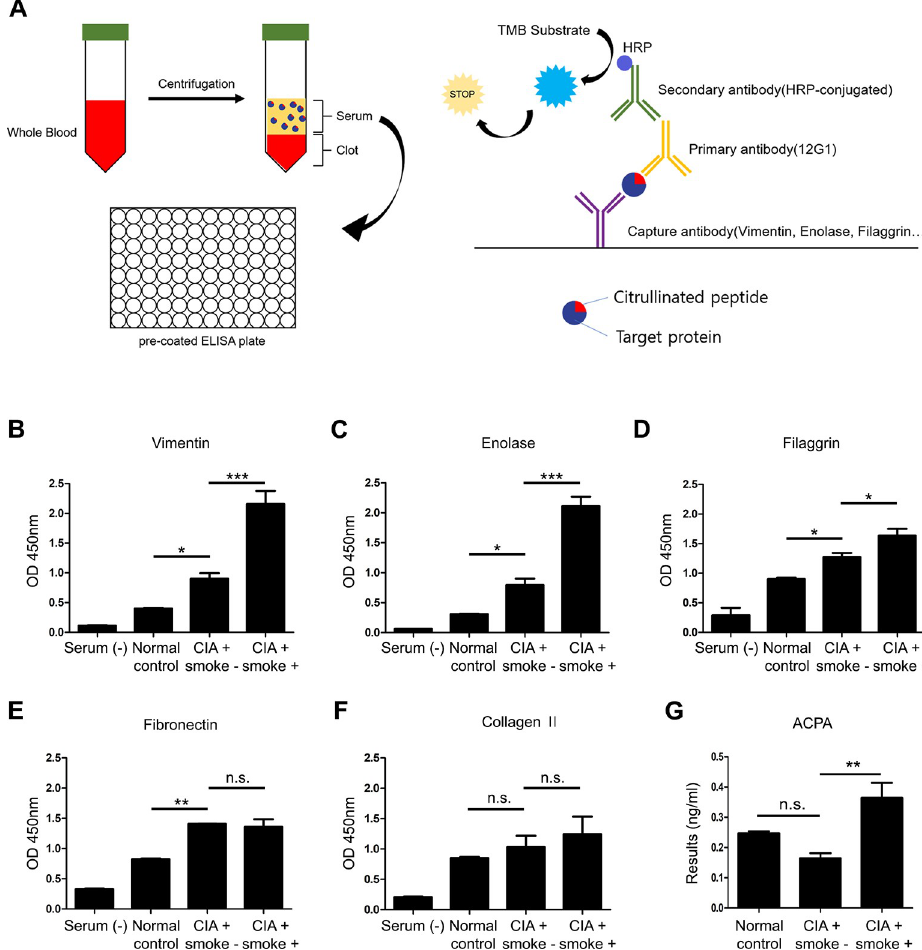
Fig 4. Serum levels of citrullinated proteins can be detected by a 12G1 antibody ELISA. (A) Diagram of the sandwich ELISA. The 12G1 antibody was used as the 1st antibody for detection of citrullinated proteins in ELISA. Levels of (B) vimentin, (C) enolase, (D) filaggrin, (E) fibronectin and (F) type II collagen detected by each antibody in mouse serum. Antibodies for each prospective protein were used as the capture antibody while the anti-CCP antibody was used as the detecting antibody. An HRP-conjugated detection antibody was used to evaluate anti-CCP antibody binding according to colorimetric change of the TMB substrate. After addition of the stop solution, absorbance was measured at 450nm. (G) Detection of anti-CCP antibody by ACPA ELISA kit. Data are the mean ± SEM, � p < 0.05; �� p < 0.01; ��� p < 0.001 by one-way ANOVA. OD, optical density; CIA, collagen-induced arthritis; ACPA, anti- citrullinated proteins antibody; n.s.,